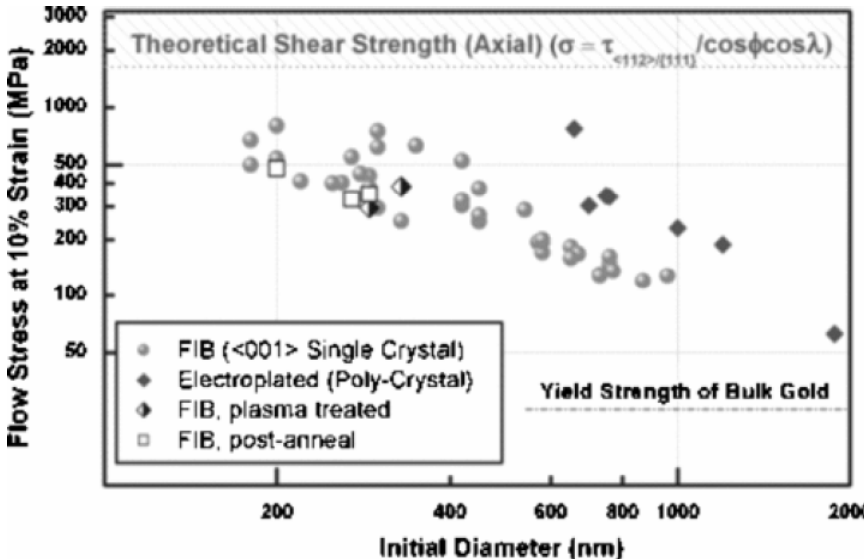
Fig. 9. Flow stress vs pillar diameter for the FIBed, electroplated, annealed, and Ar plasma-treated pillars compared with the range of theoretical strength and the yield strength of bulk Au. Reprinted with permission from Greer JR, Nix WD. 2006. Nanoscale gold pillars strengthened through dislocation starvation. Physical Review B 73, [6]: ©2006 American Physical